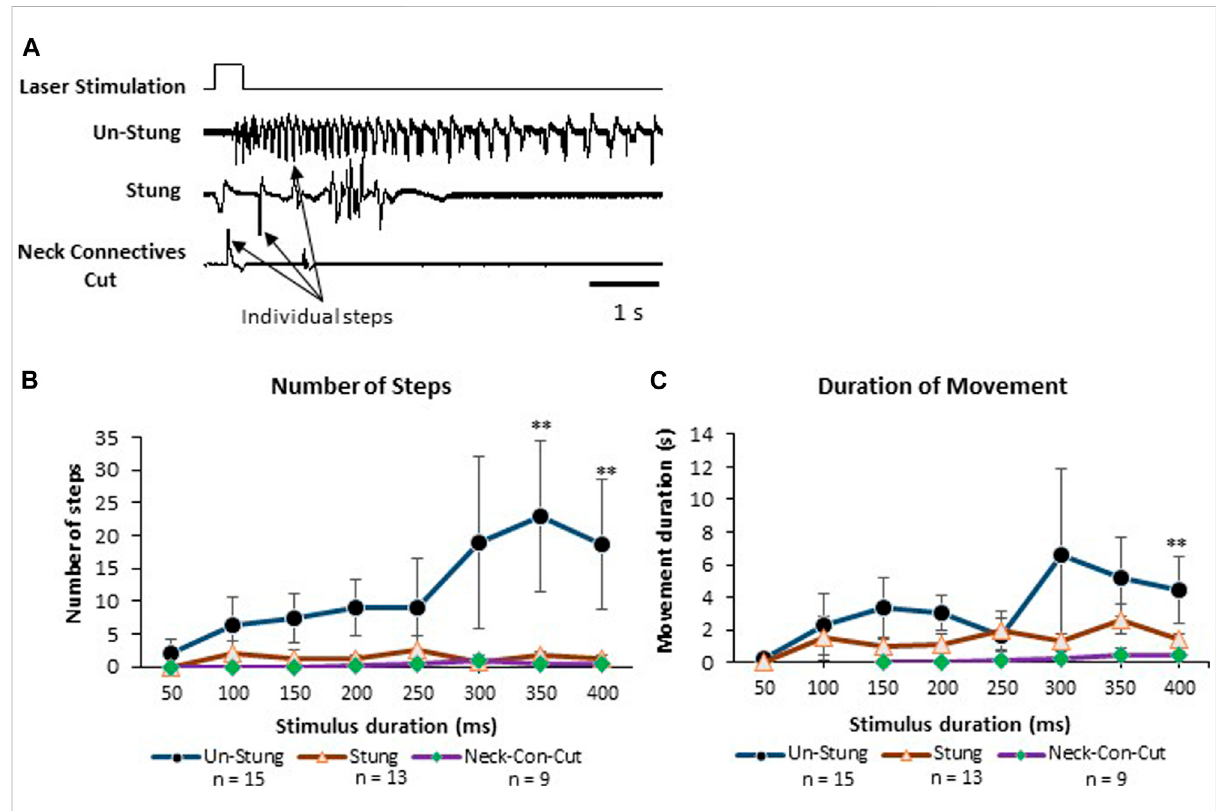
Stung andNeckConnectives Cut cockroaches failto performan escaperesponseinresponseto apurenoxiousstimulus. (A) cockroaches ’ Leg movements (which represent walking or running) of Un-Stung (upper trace), Stung (middle trace) and Neck Connectives Cut (lower trace) in response to a 400 ms laser stimulus to the abdomen. Stimulus duration is indicated above the three traces. Individual steps are indicated by arrows. (B,C) PlotsshowingtheAverage±SEMoftheNumberofSteps (B) ,theDurationofMovementinseconds (C) .Signi fi